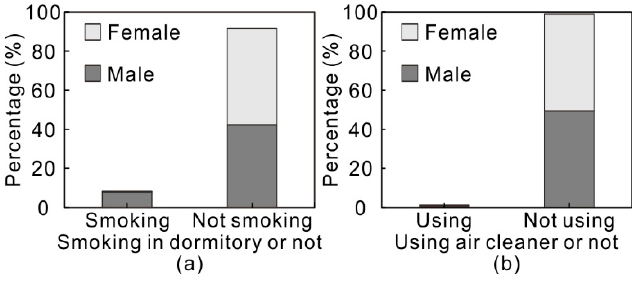
Figure 3. ( a ) Smoking in dormitory or not; ( b ) Using air cleaner in dormitory or not.